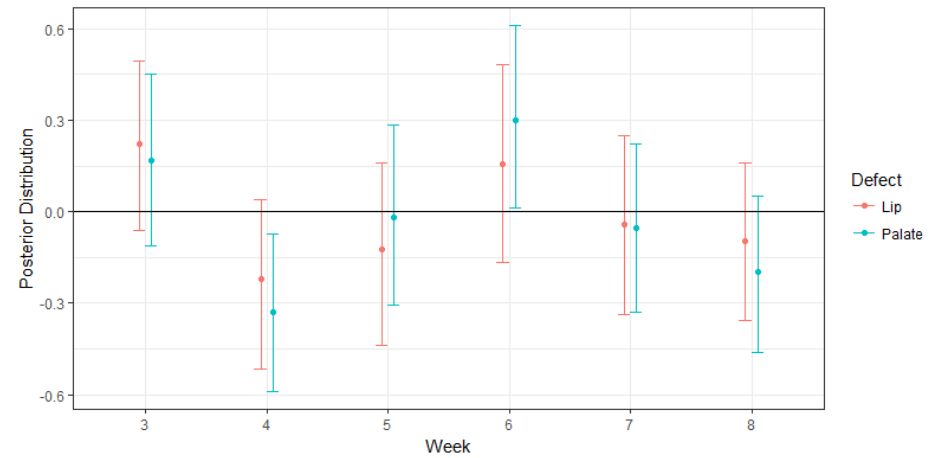
Figure 3. Weekly association of latent pollutants factors ( w (cid:96) m ) for the one-factor model. The effects are summarized by their posterior means (dots) and 95% credible intervals (vertical lines) for a change in cleft defects with a one-standard deviation increase in the mixture of pollutant exposure during weeks 3 through 8 post-conception in the National Birth Defects Prevention Study, 2003–2007. The factor pollutants are adjusted for maternal age, education, maternal smoking, and maternal alcohol use. Weeks 4, 5, 7 and 8 are associated with a slightly lower probability of having a cleft palate defect, whereas exposure during weeks 3 and 6 is associated with a slight increase in the probability of having a cleft palate